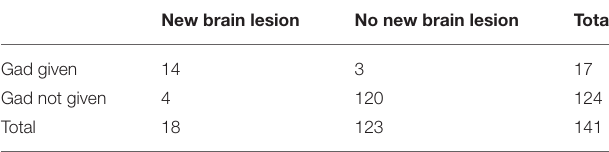
TABLE 1 | GBCA reduction initiative: results from the 2 month feasibility study.